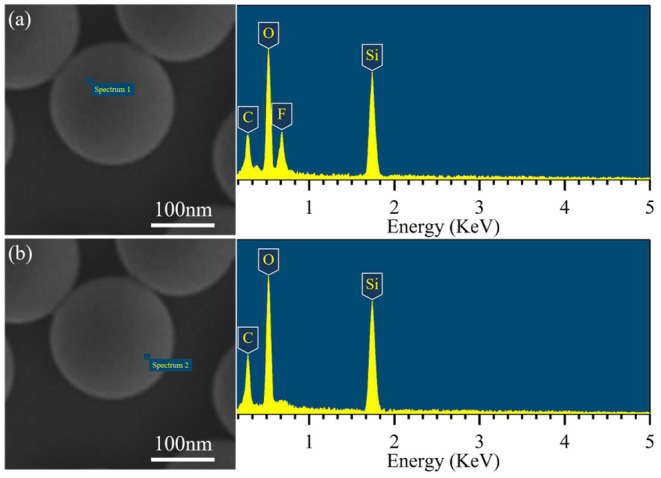
EDS-point scanning of the JP1s. (a) Corresponding to the side covered by perfluoroalkyl segments side; (b) corresponding to the side covered by alkyl segments.